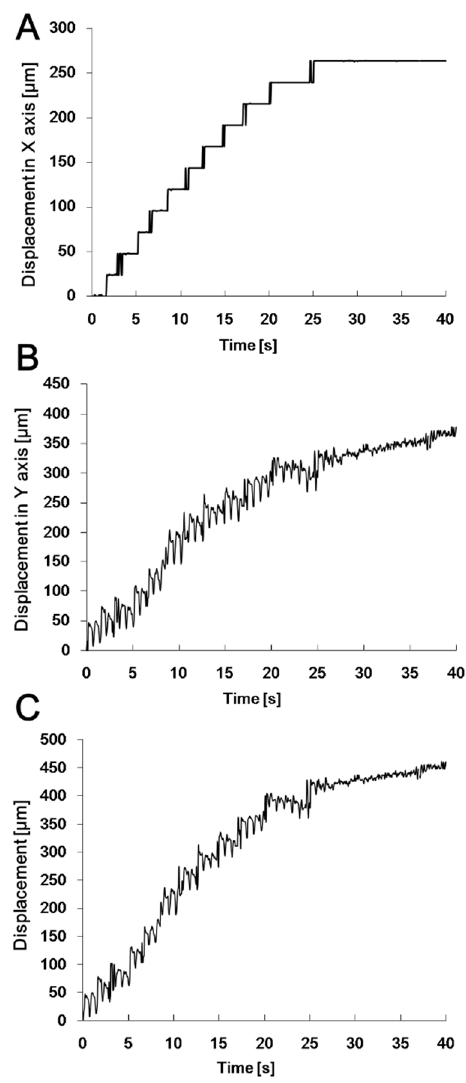
Figure 9. The motion analysis results obtained for the swimming robot. The direction of swimming was separated into X-axis and Y-axis motions. ( A ) Displacement of the swimming robot on the X-axis. ( B ) Displacement of the swimming robot on the Y-axis. ( C ) Total displacement of the swimming robot.